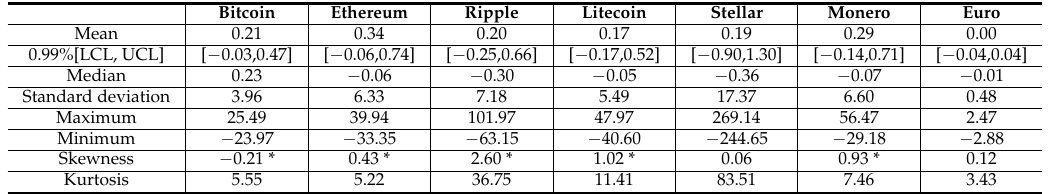
Figure 1. Bitcoin, Litecoin, and Ethereum prices and return dynamics along time. Table 1. Returns basic statistics. (Notation in table: * means 5% statistical significance). Bitcoin Ethereum Ripple Litecoin